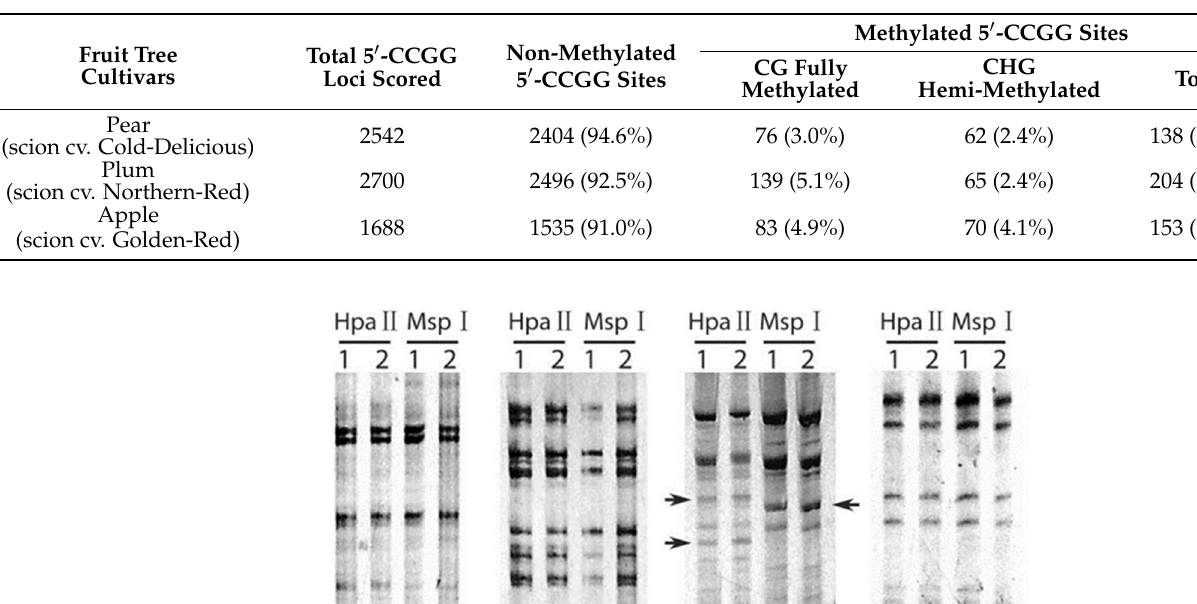
Table 1. Number of CCGG loci analyzed by MSAP in the three fruit tree scion cultivars.